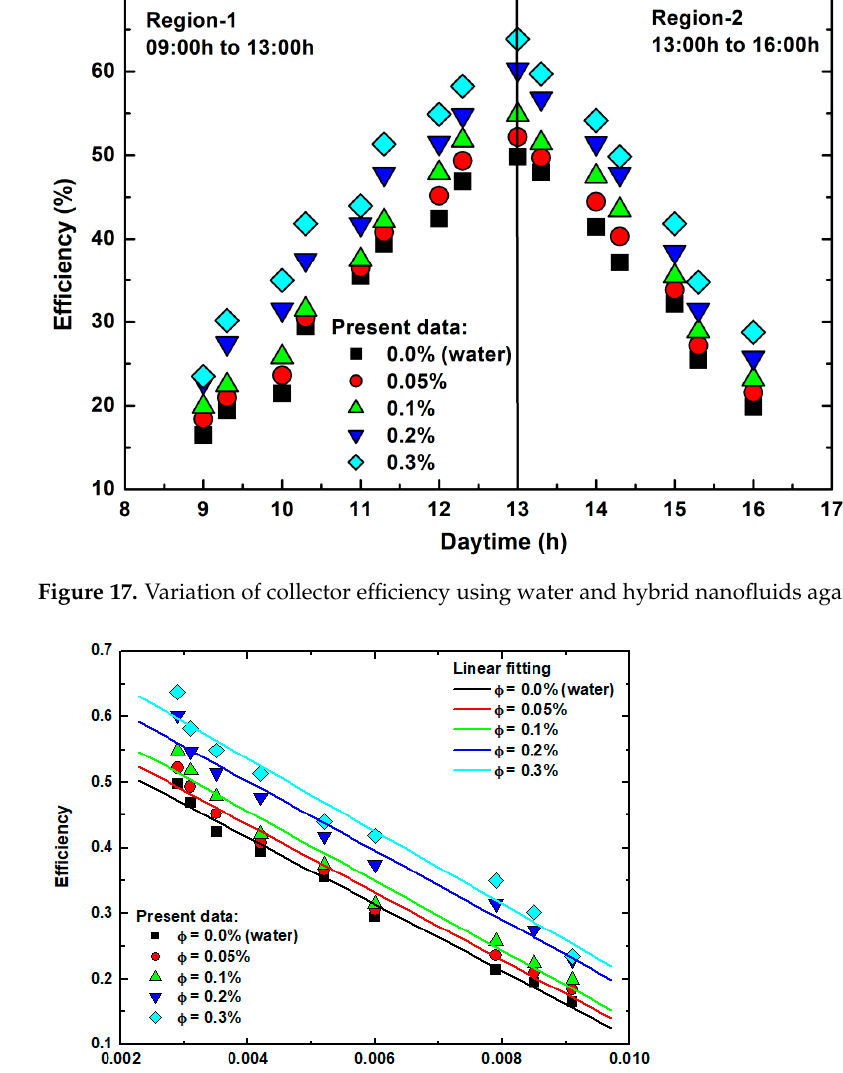
Figure 18. Instantaneous collector efficiency versus (𝑇 (cid:3036) − 𝑇 (cid:3028) 𝐺 (cid:3021) ⁄ ) parameter.